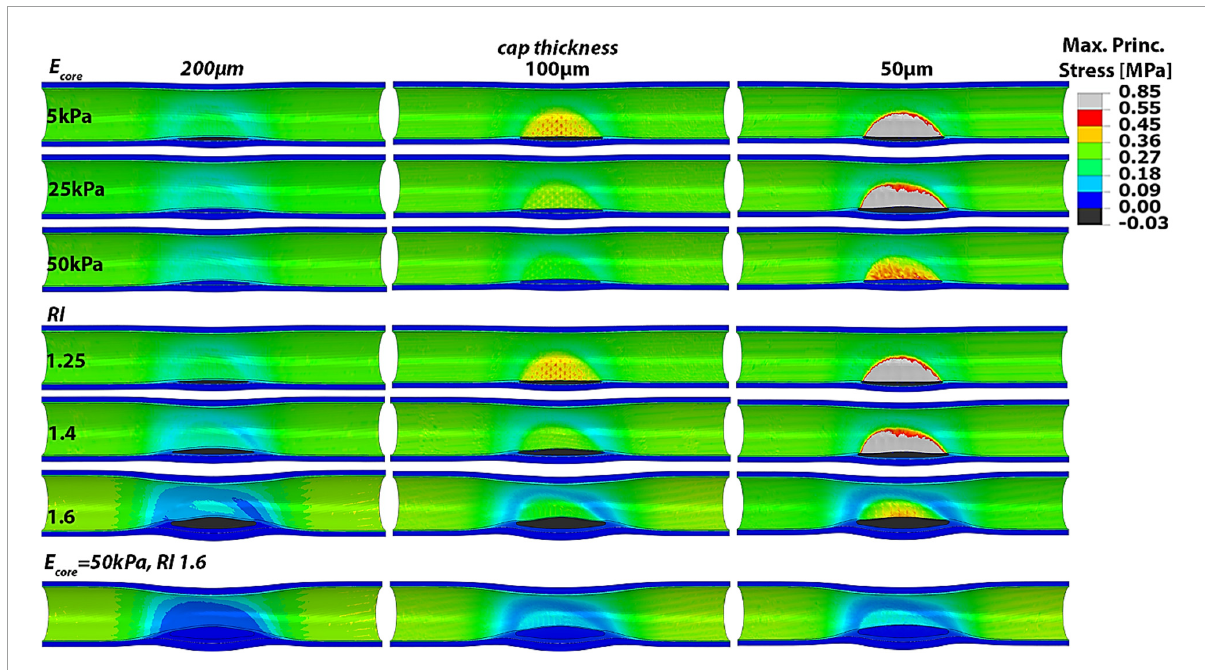
FIGURE3 Longitudinal cut of idealized models with varying RI, Ecore and cap thickness showing the Max Principal Stress distributions. Higher remodeling indices and stiffer lipid cores clearly influence the PCS and the location of highest wall stress.